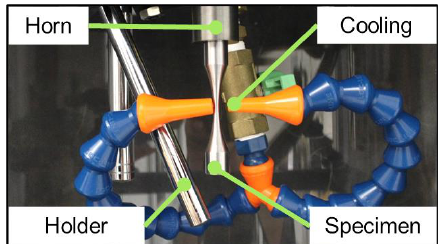
Figure 5. Experimental setup of an ultrasonic fatigue testing system equipped with a pneumatic air cooling system.